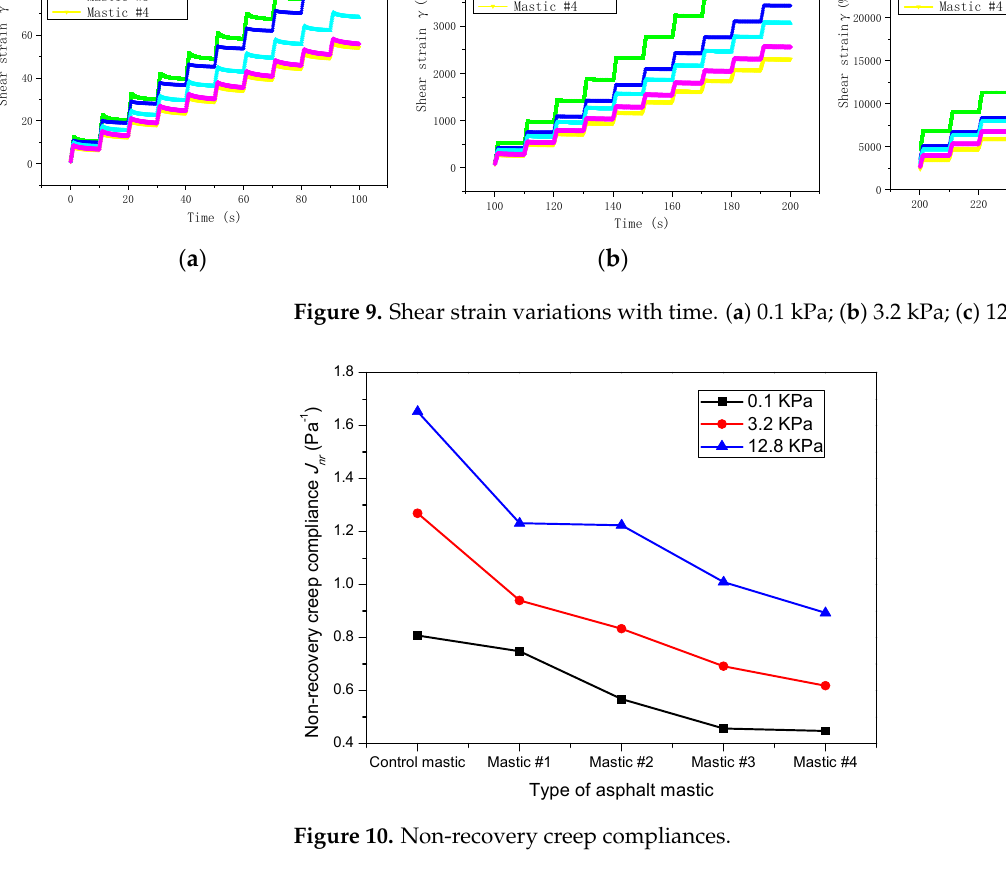
(i.e., 0.1 kPa, 3.2 kPa, and 12.8 kPa, respectively).